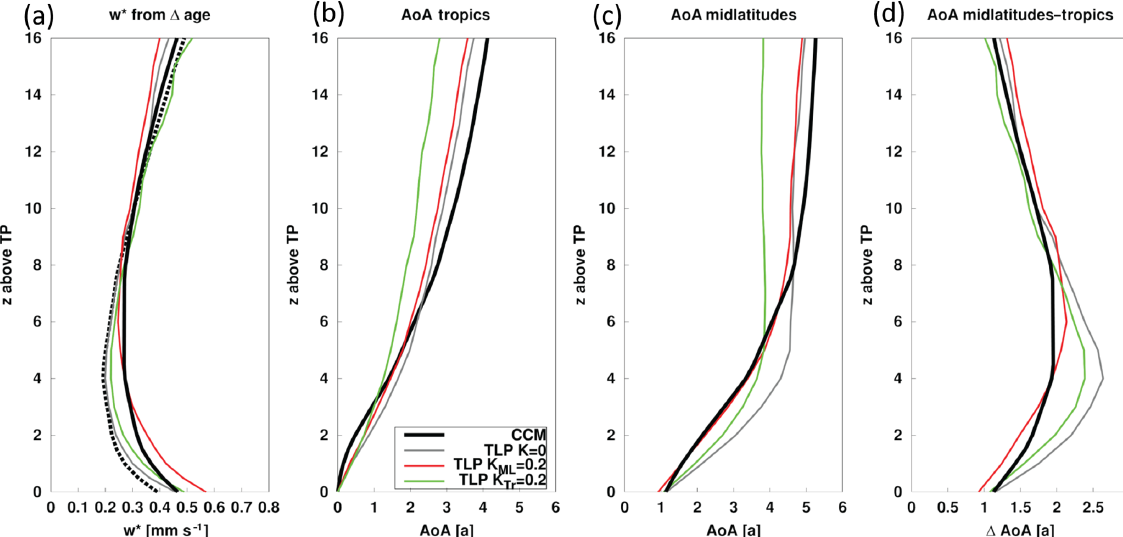
Figure 7. (a) Tropical mean (20 ◦ N–20 ◦ S) vertical residual velocities (black dashed) from one model (EMAC-L90) and effective tropical velocities derived from the tropics-to-midlatitude age difference in EMAC-L90 (black solid), in a TLP model driven by vertical velocities from EMAC-L90 and without diffusion (gray), with vertical diffusion of K = 0 . 2m 2 s − 1 in the tropics (green) and the extratropics (red). (b) Tropical (20 ◦ N–20 ◦ S) AoA profiles from EMAC-L90 (black solid) together with AoA profiles simulated by a TLP model with no vertical diffusion (gray line, identical to analytical TLP solution used to derive the mixing efficiencies), with vertical diffusion of K = 0 . 2m 2 s − 1 in the tropics (green) and the extratropics (red). (c) Same as (b) but for midlatitude AoA profiles (35–45 ◦ N and 35–45 ◦ S). (d) Difference between midlatitude and tropical AoA